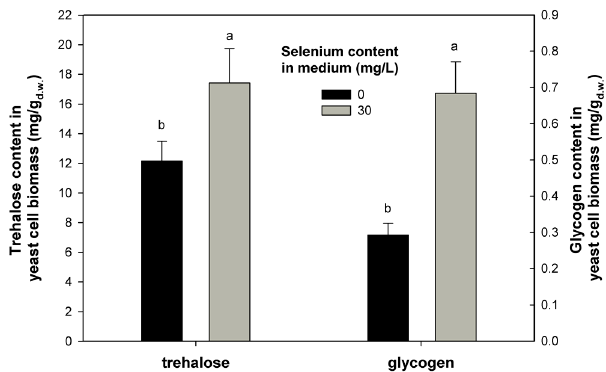
Figure 3. Effect of selenium on trehalose and glycogen content in C. utilis yeast cells. Means with the same letter (a,b) did not differ significantly (acc. Tukey’s HSD